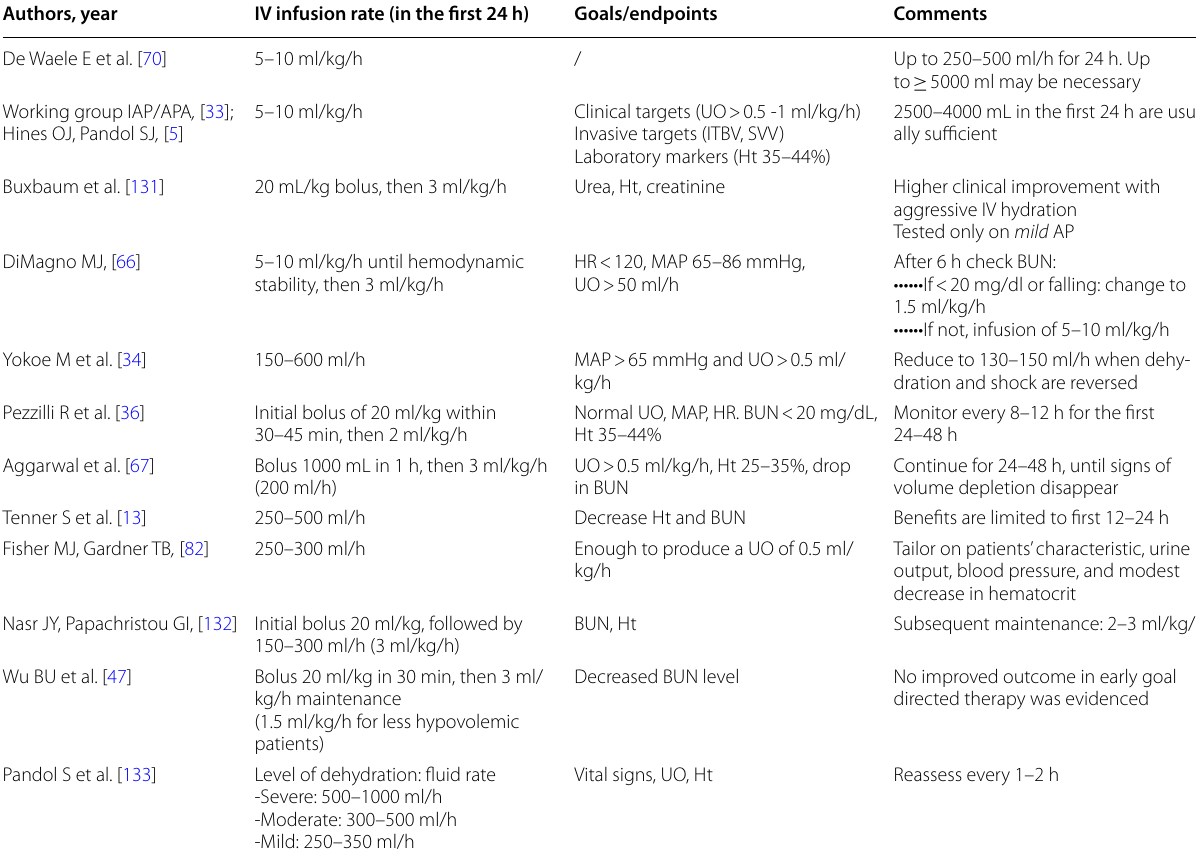
AP Acute Pancreatitis; BUN Blood urea nitrogen; HR Heart rate; Ht Hematocrit; ITBV Intrathoracic blood volume; MAP Mean arterial pressure; UO Urine output; SVV Stroke volume variation; / Not